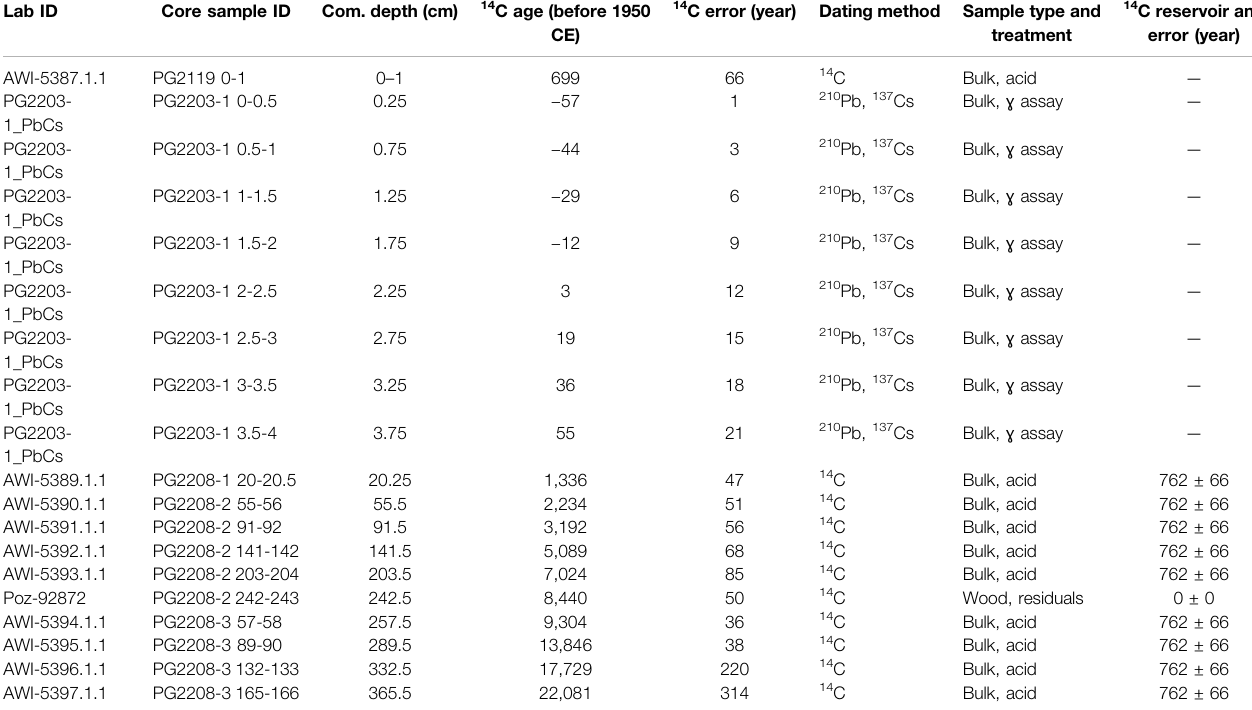
TABLE 1| Listofsamplesand datingmethods used for age-depth modelling.All datesareconvertedtoC14 ages relative to1950 CE.All dating results from MICADAS and Liverpool are shown. Just one Poznan date on wood residuals (Courtin et al., 2021) was used in this study. The composite depth indicated as “ Com. Depth (cm) ” represents the total depth below the sediment surface; the speci fi c depth (cm) within core sections is indicated in “ Core sample ID ” . Lab